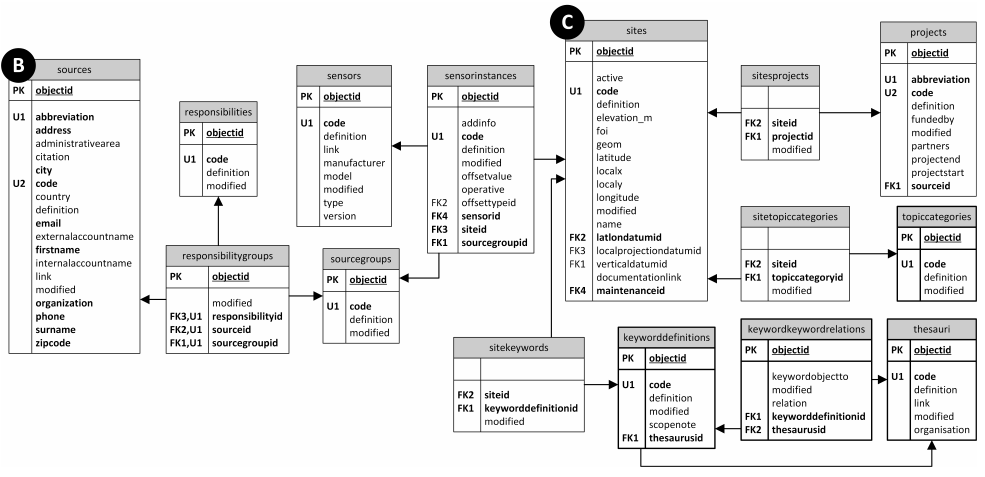
Figure 4. A sensorinstance only belongs to a specific sourcegroup